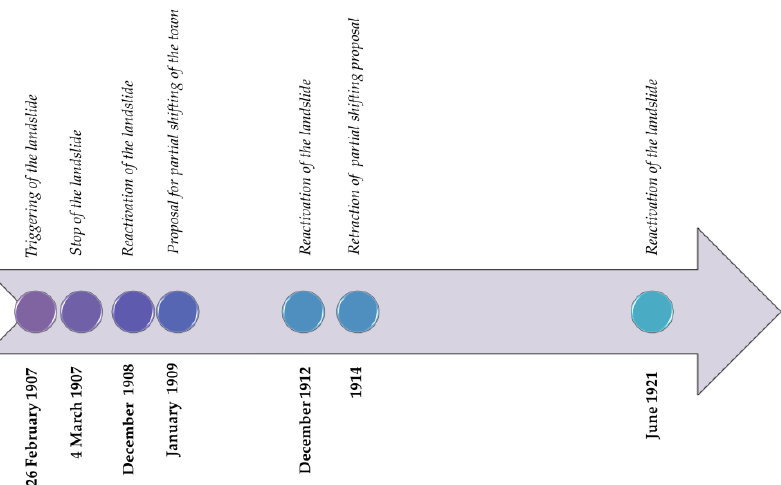
Figure 13. The landslide body ( left , right ) and the damage caused to a retaining wall ( right ) (Source: [67], private archive of Gizzi F.T.). On the third day, the landslide body was overestimated to have a length of about 2 km and a width of comparable dimensions. Four days after the first movement, the